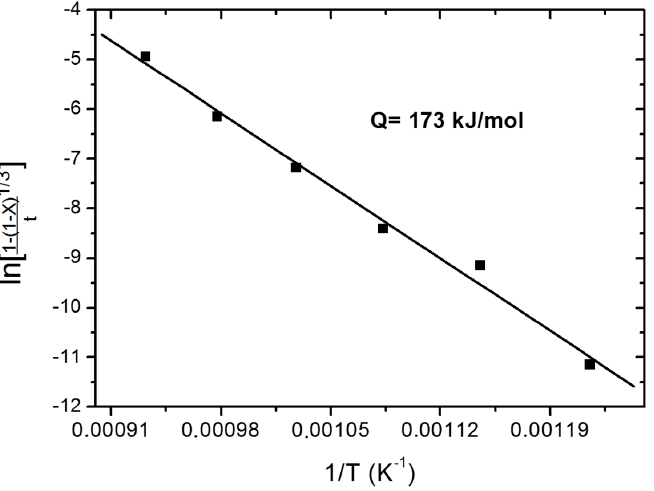
Figure 2. Arrhenius plot for the isothermal reduction of shallow powder beds of Fe 2 MoO 4 [2].